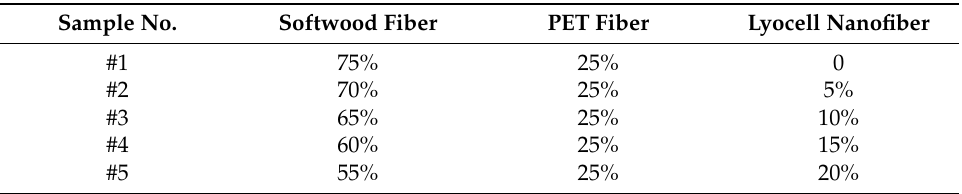
Table 1. Weight fraction of fibers in filter